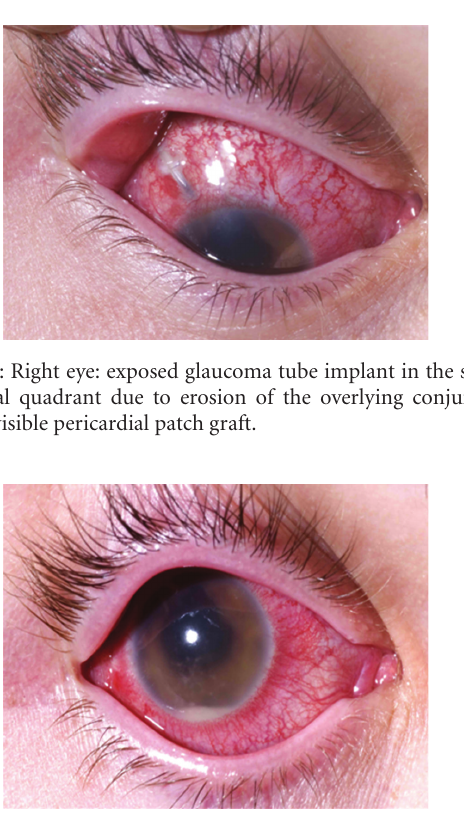
Figure 3: External photo of right eye showing an inflamed conjunctiva, hazy cornea, and hypopyon in the anterior